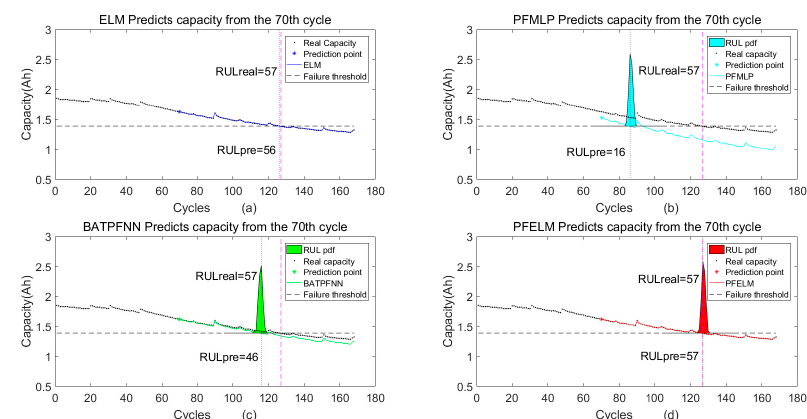
Figure 7. Capacity prediction error from the 50th cycle.